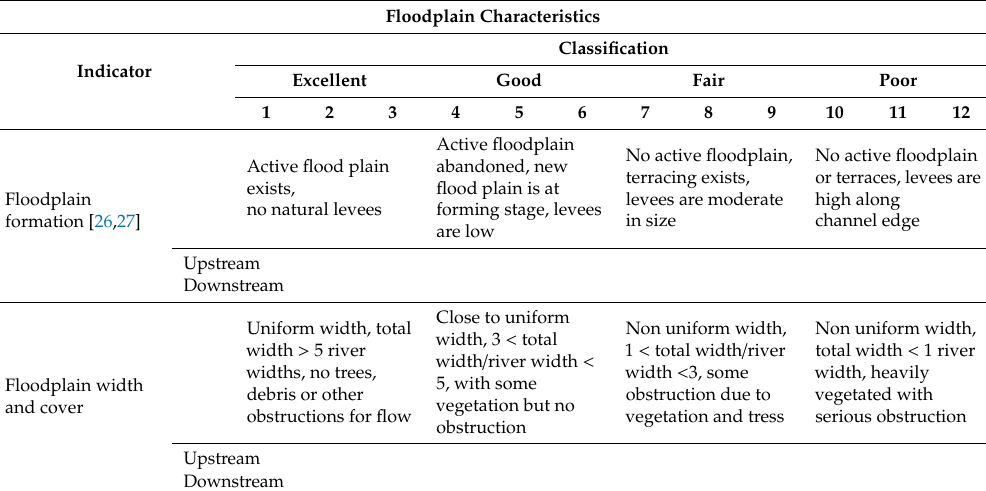
Table 4. Floodplain